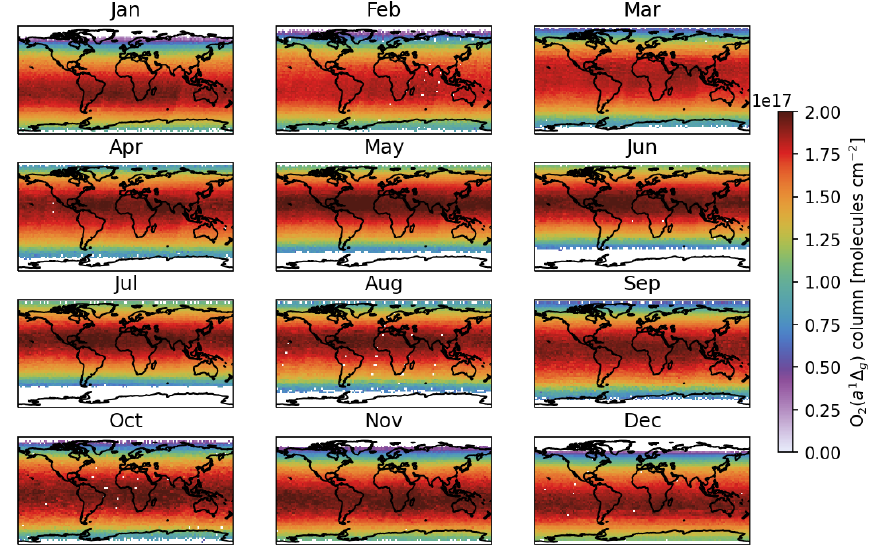
Figure 9. Monthly average of O 2 (a 1 (cid:49) g ) column number density retrieved from SCIAMACHY nominal limb